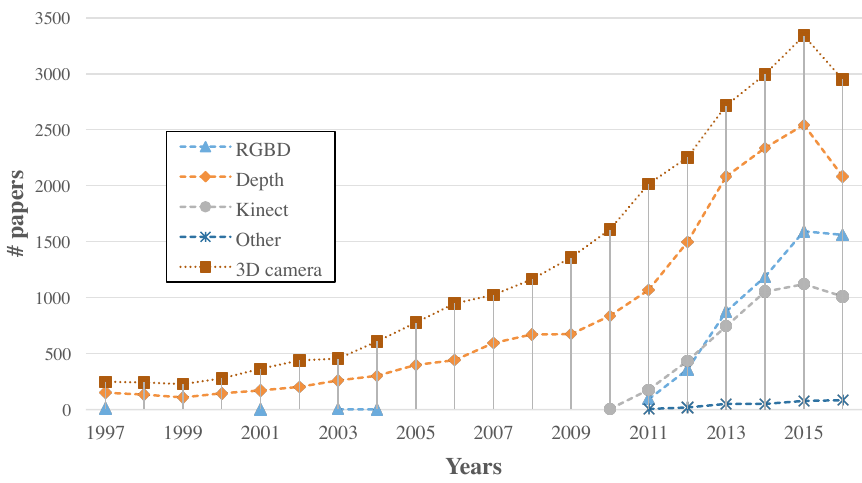
Figure 1. Number of publications calculated from Scopus containing 3D imaging, depth cameras, RGB-D cameras, Microsoft Kinect sensors and other devices (including Asus Xtion, Primesense and Intel